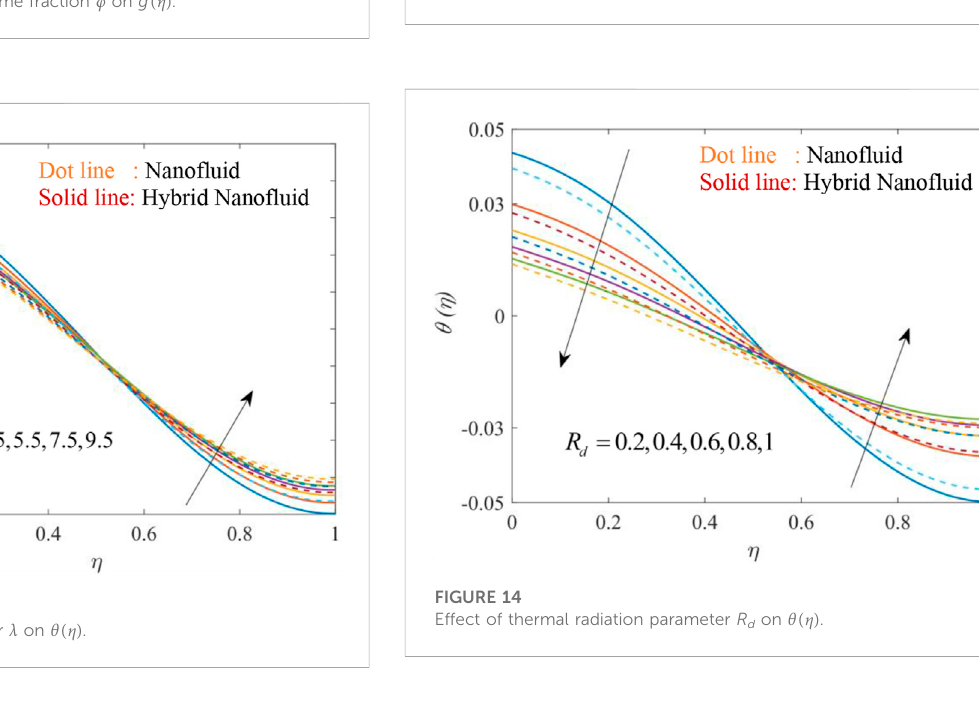
FIGURE 13 Effect of Magnetic fi eld parameter M on θ ( η ) .